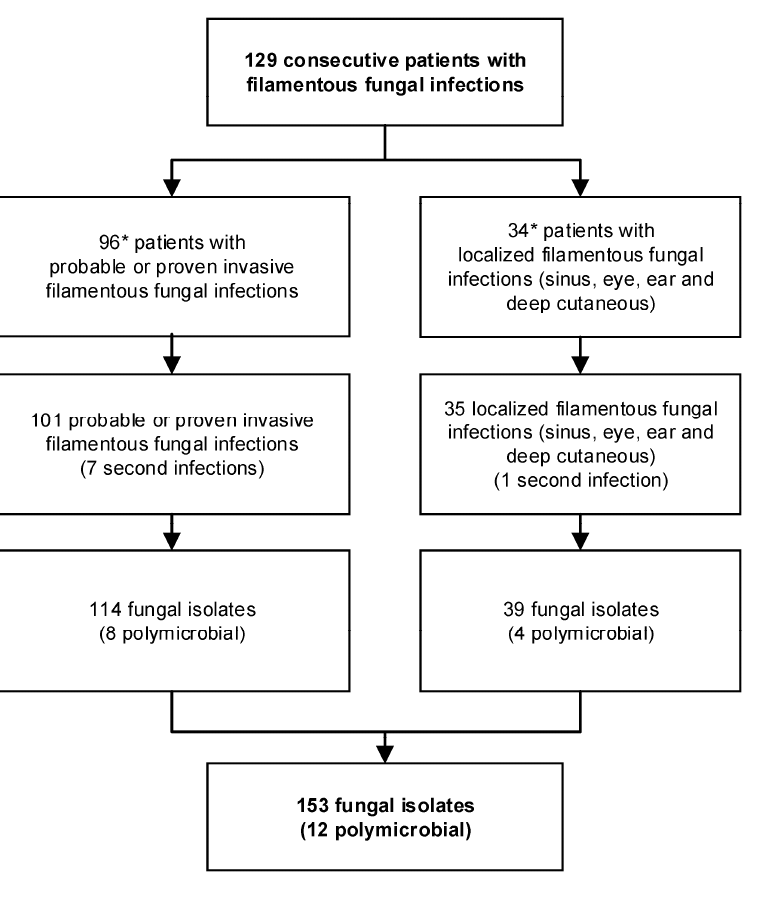
Figure 1. Flow chart shows number of patients, infections, and isolates included in analysis. The median age was 52 years (range 4–82 years); 61 (47.3%) patients were female.